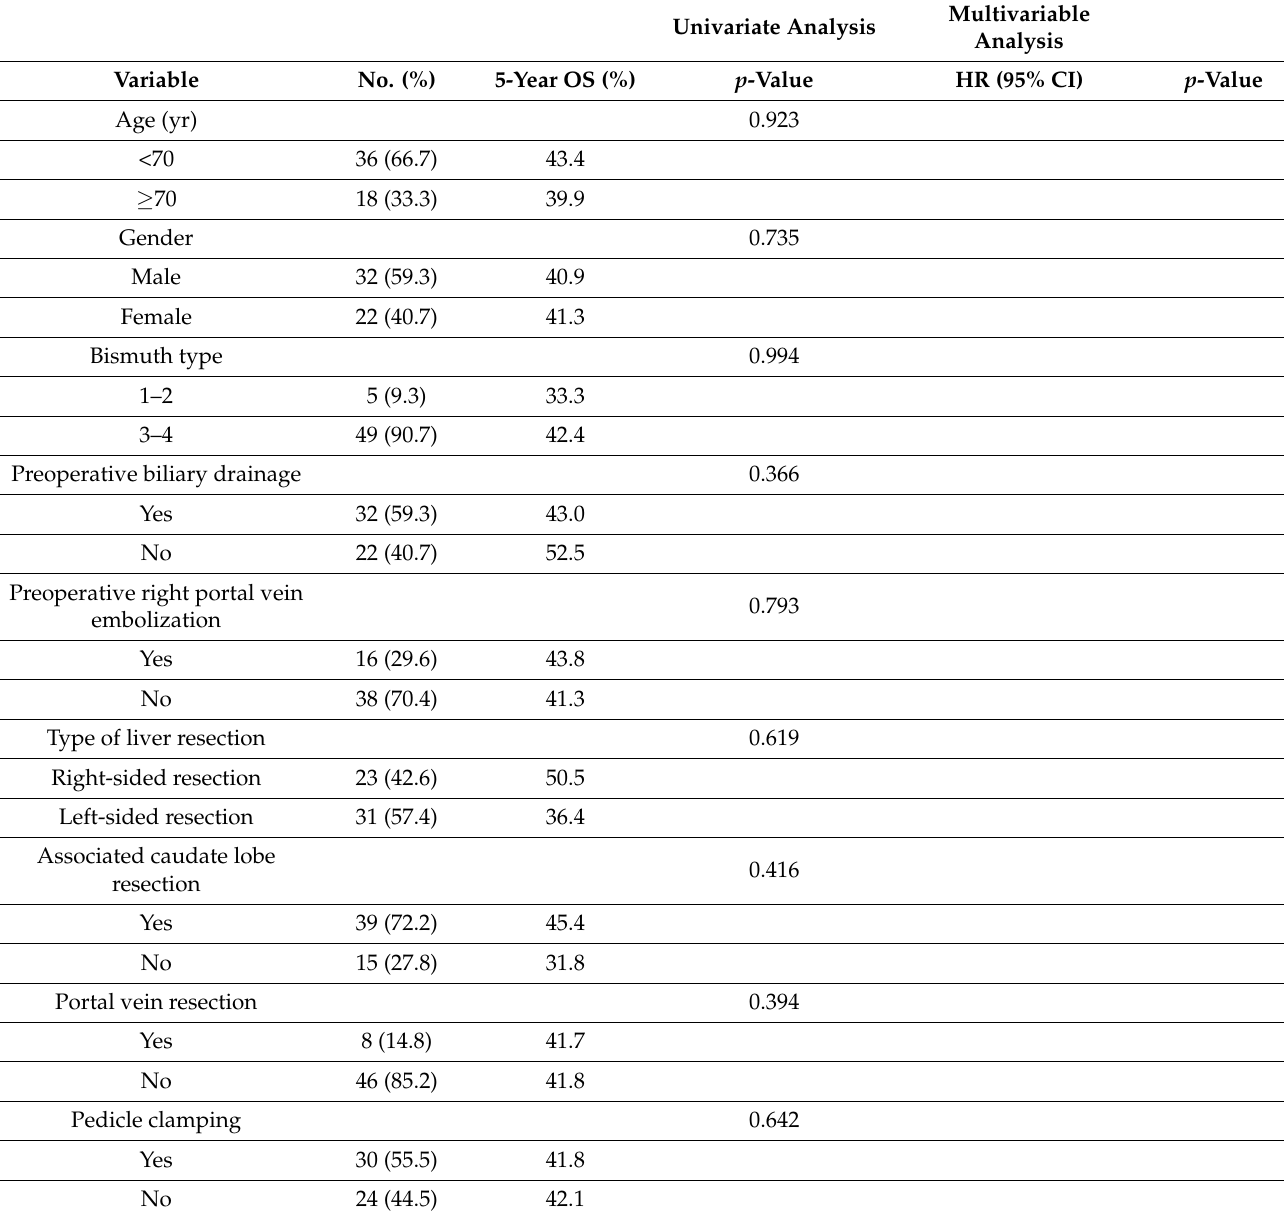
Table 5. Univariate and multivariable analysis of OS in 54 resected patients for PHC. Univariate Analysis